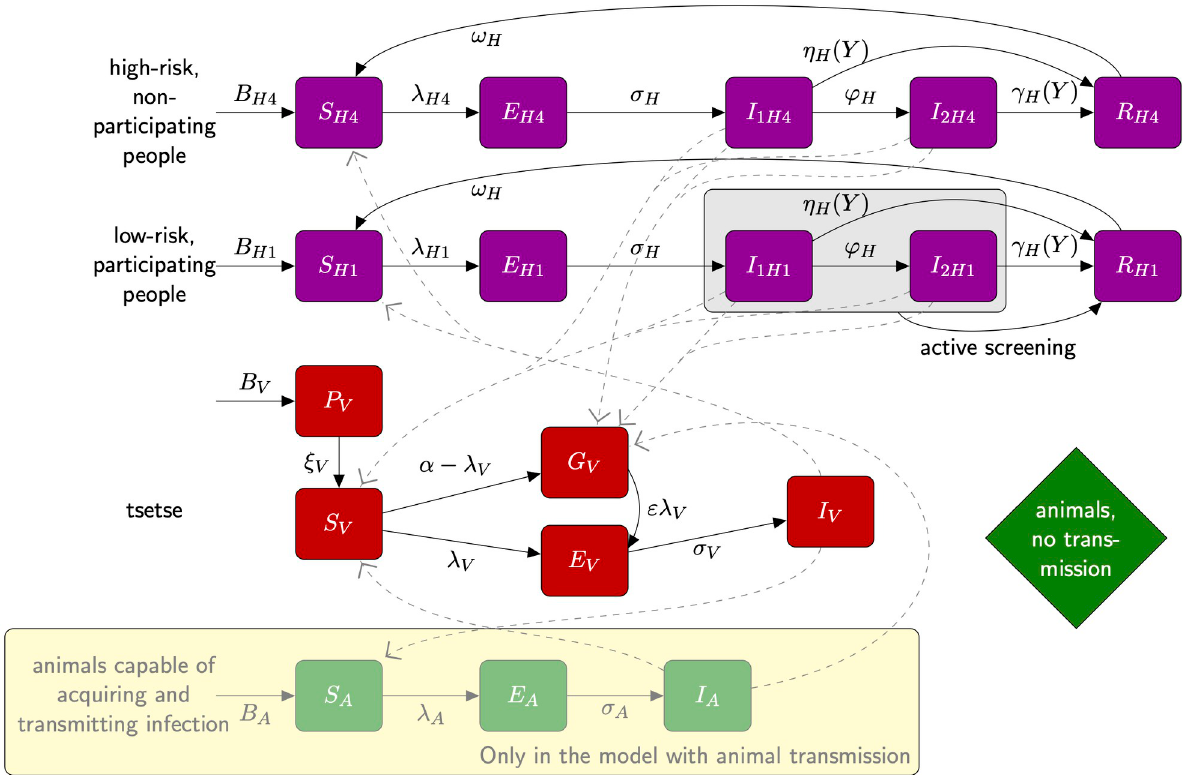
Fig 1. Warwick gHAT compartmental model variants with and without animal transmission. Purple boxes denote human infection states, with low-risk people who randomly participate in AS denoted with subscript H 1 and high-risk people who do not participate denoted with subscript H 4 (we retain this notation to align with previously published versions of this model). Tsetse are represented by red boxes and we explicitly include a pupal stage ( P ) and differentiate between unfed (teneral) flies ( S ) and non-infected but fed flies ( G ) to incorporate reduced tsetse susceptibility V V V following the first bloodmeal. For simplicity, the exposed category for tsetse is shown as a single compartment, E V ; within the model this is subdivided into three compartments, E 1 , E 2 and E 3 , to model parasite development. The pathway relating to the animal infection and transmission, which is V V V specific to the model with animal transmission, is highlighted with a pale yellow box. Solid lines represent transition within a pathway, while broken lines represent transmission. More details and model equations can be found in S1